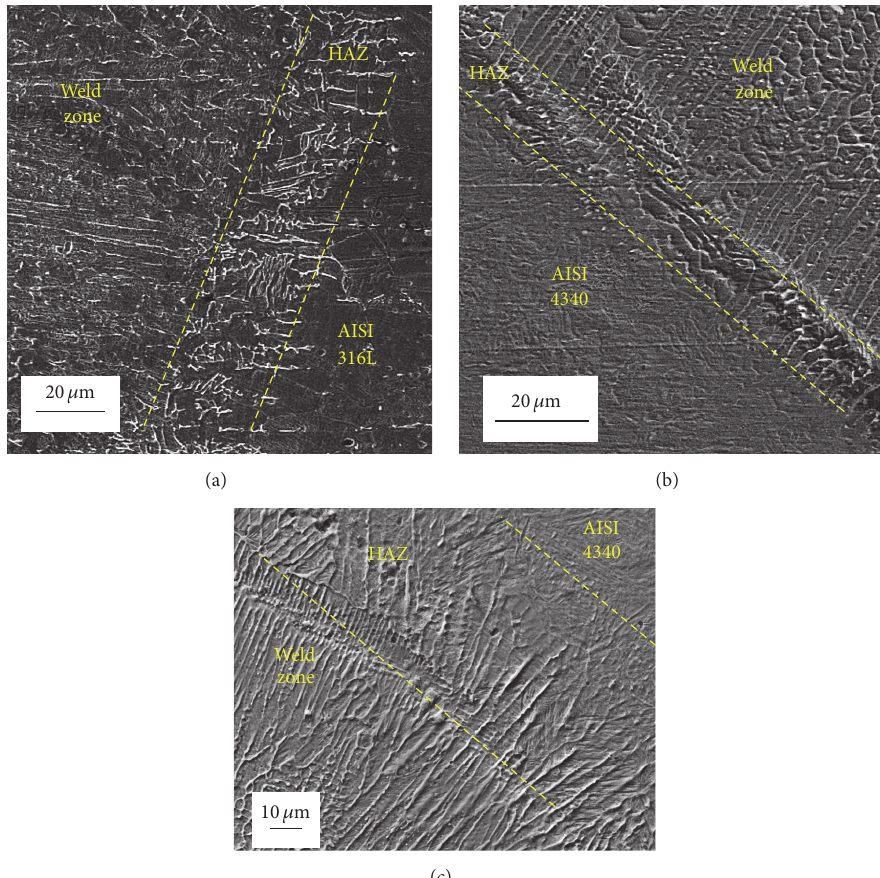
Figure 17: The HAZ of welded specimens: (a) AISI 316L side (sample number 3), (b) AISI 4340 side (sample number 3), and (c) AISI 4340 side (sample number 5).